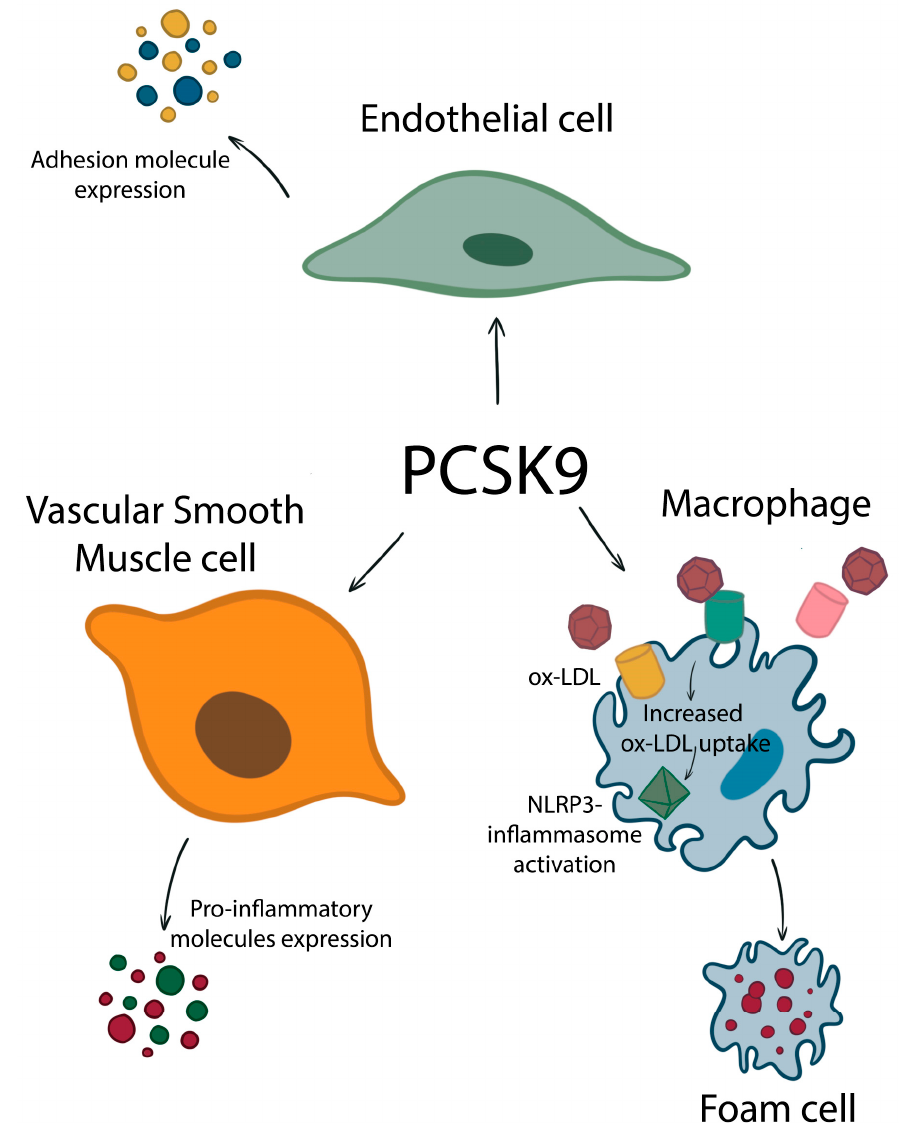
Figure 2. PCSK9 increases the expression of various receptors, increasing the uptake of ox-LDL. This leads to activation of NLRP3-inflammasome and increased foam-cell formation. Endothelial cells produce more adhesion molecules under the influence of PCSK9, and smooth muscle cells release more pro-inflammatory molecules.